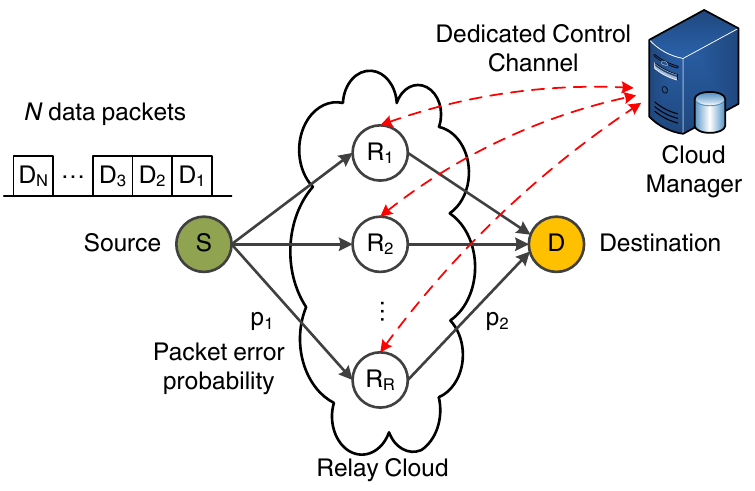
Figure 2. System